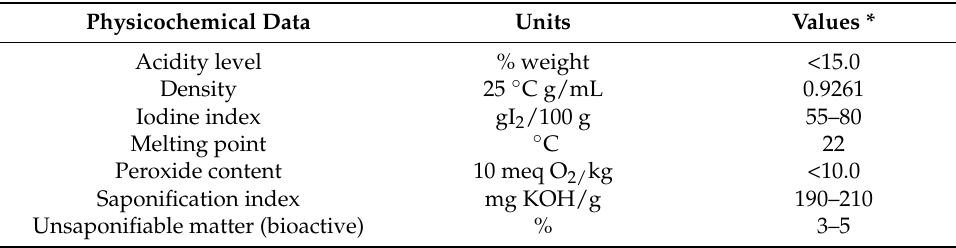
Table 1. Physicochemical properties of commercial andiroba oil.